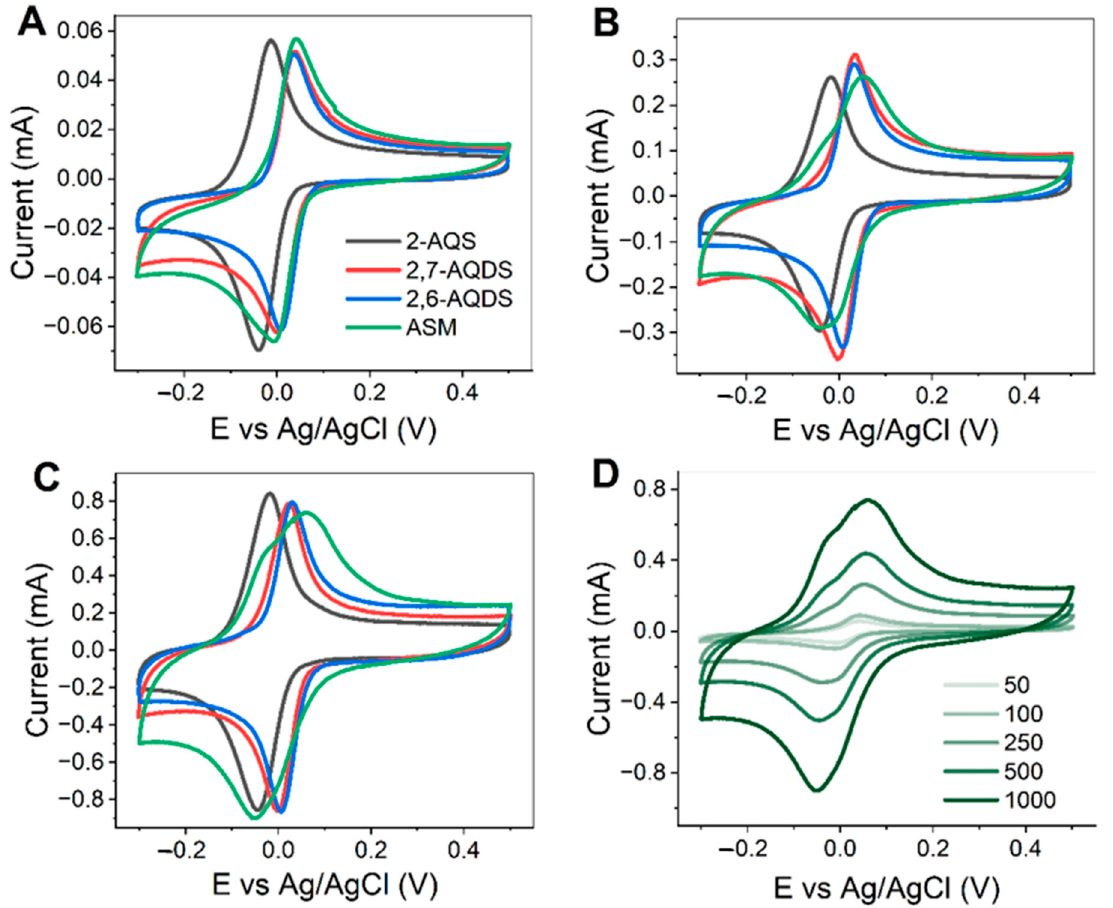
Figure 3. Cyclic voltammograms for 2,7-AQDS, 2,6-AQDS, 2-AQS and ASM. Total concentration of sulfonated derivatives—1 mM, supporting electrolyte—1 M H 2 SO 4 . Scan rate: ( А ) 50 mVs − 1 ( B ) 250 mVs − 1 ( C ) 1000 mVs − 1 . ( D ) represents CV of ASM for scan rate from 50 mVs − 1 to 1000 mVs − 1 .